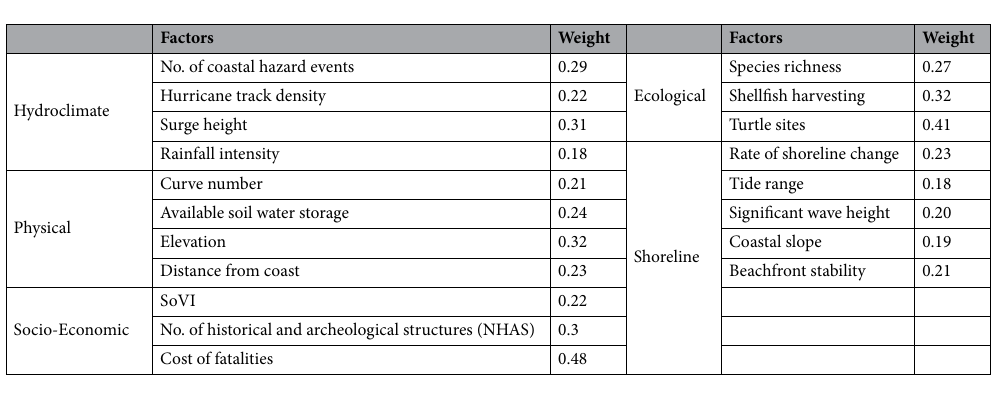
Table 4. Weight of the factors from entropy